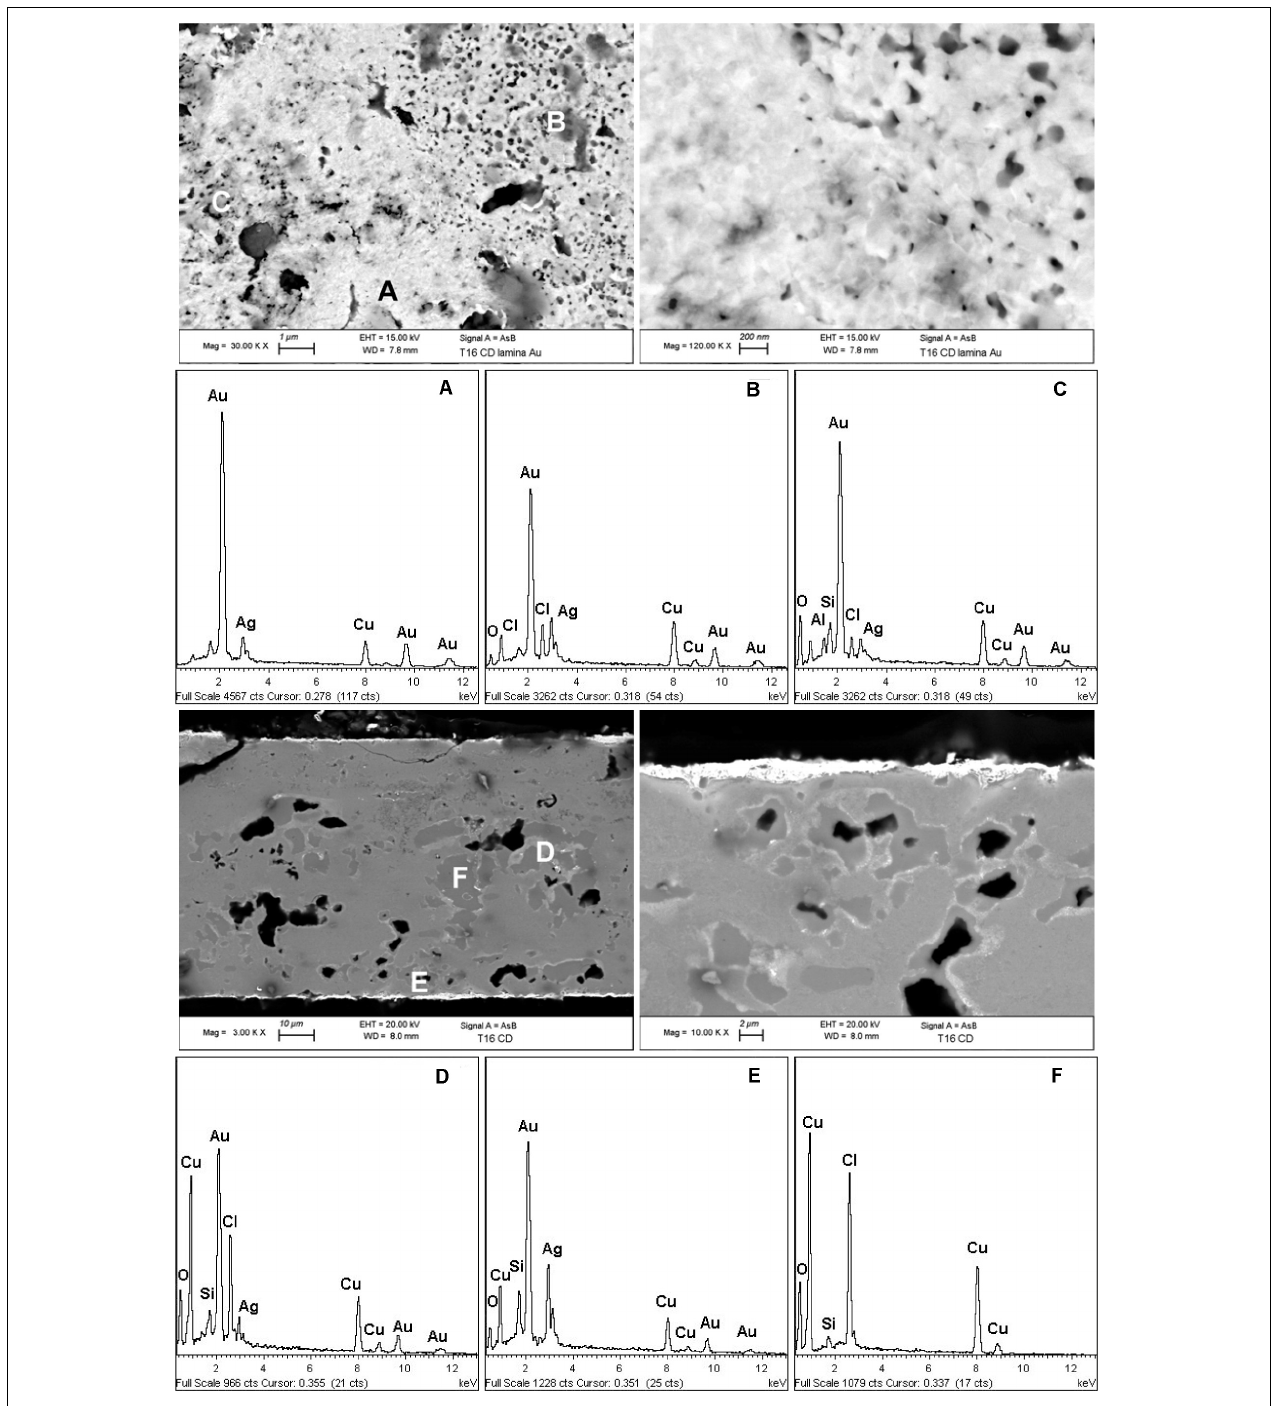
FIGURE 2 | SEM images and the EDS spectra (A–F) of a fragment of a gilded plaque completely mineralized found in the tomb T16 of the warrior with a ceremonial trumpet called Pututo. The results describe the microchemistry and the morphology of the surface gold-enriched layer present on both sides as well as show the internal corroded structure of the